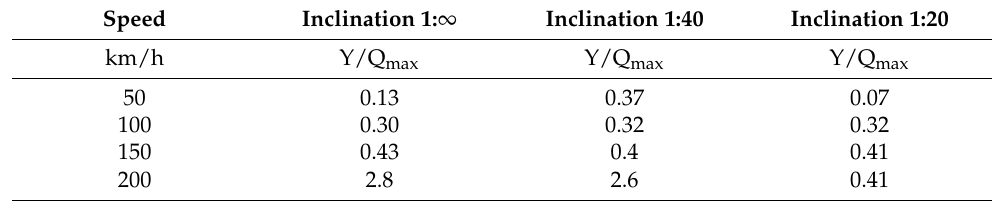
Table 3. Values of the Y/Q derailment ratio for different speed values and different rail inclinations.